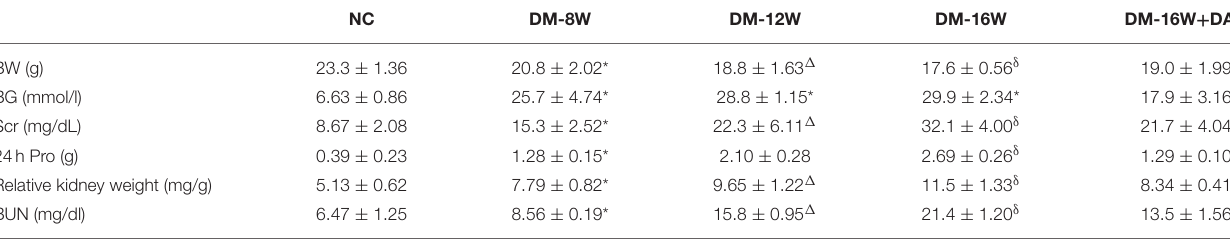
TABLE 3 | Influence of dapagliflozin on renal functional parameters in diabetic mice.